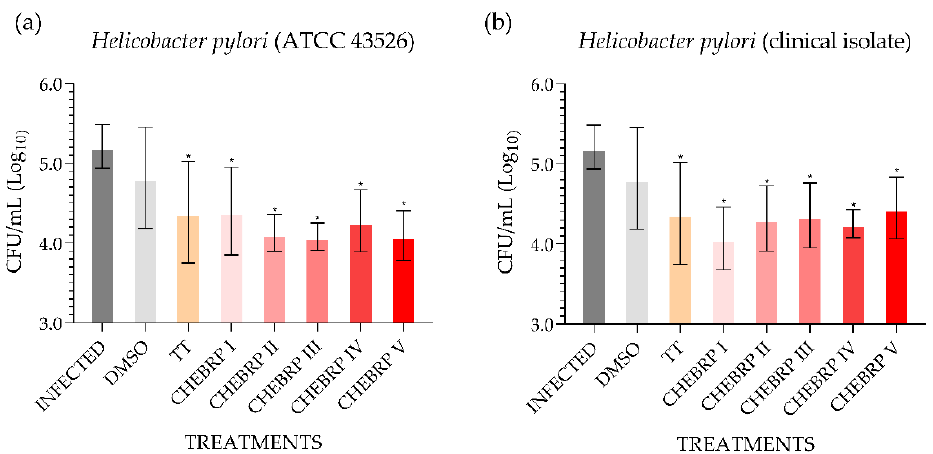
Figure 2. Quantitative determination of the presence of Helicobacter pylori in the stomach mucosa (antrum) of Wistar rats. DMSO—dimethyl sulfoxide. TT—triple therapy (amoxicillin 50.0 mg/kg, clarithromycin 25.0 mg/kg, and omeprazole 20.0 mg/kg). CHEBRP—concentrations of crude hy- droalcoholic extract of Brazilian red propolis (I: 18.25 mg/kg; II: 37.5 mg/kg; III: 75.0 mg/kg; IV: 150.0 mg/kg and V: 300.0 mg/kg). ( a ) Determination of the quantity of Helicobacter pylori (ATCC 43526) in the gastric antrum after treatments. ( b ) Determination of the quantity of Helicobacter pylori (clinical isolate) in the gastric antrum after treatments. * p < 0.05 compared to control (infected). Histopathological analyses were performed to qualitatively evaluate the inflamma- tory infiltrate, activity, epithelial atrophy and presence of metaplasia. In the evaluation of the histological sections, it was determined that CHEPBR at a concentration of 300.0 mg/kg and triple therapy (TT: amoxicillin 50.0 mg/kg, clarithromycin 25.0 mg/kg, and omeprazole 20.0 mg/kg) were the only treatments performed that were capable of decreas-